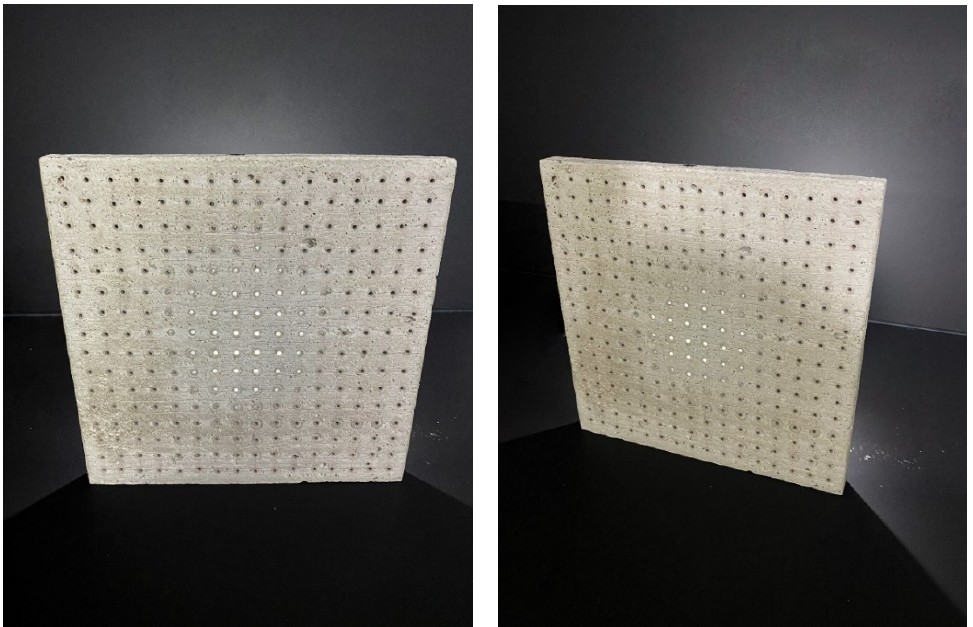
Figure 11. Concrete slab with air holes.